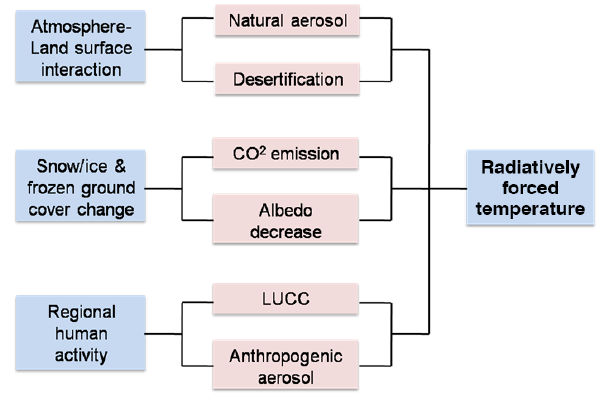
Figure 15. Schematic diagram of radiatively forced temperature. LUCC represents land use and land cover